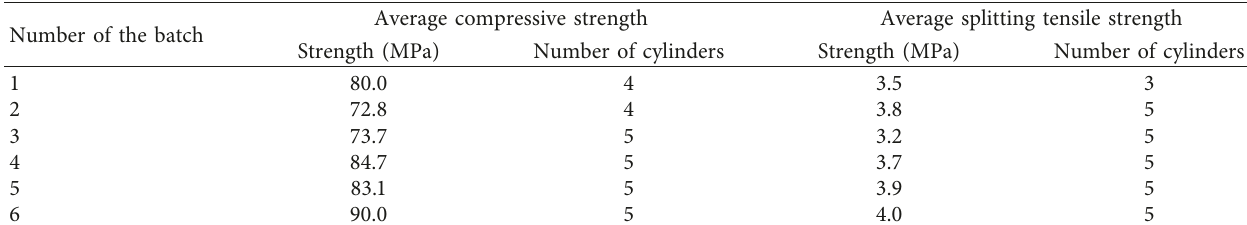
Table 2: Compressive strength and splitting tensile strength of high-strength concrete.